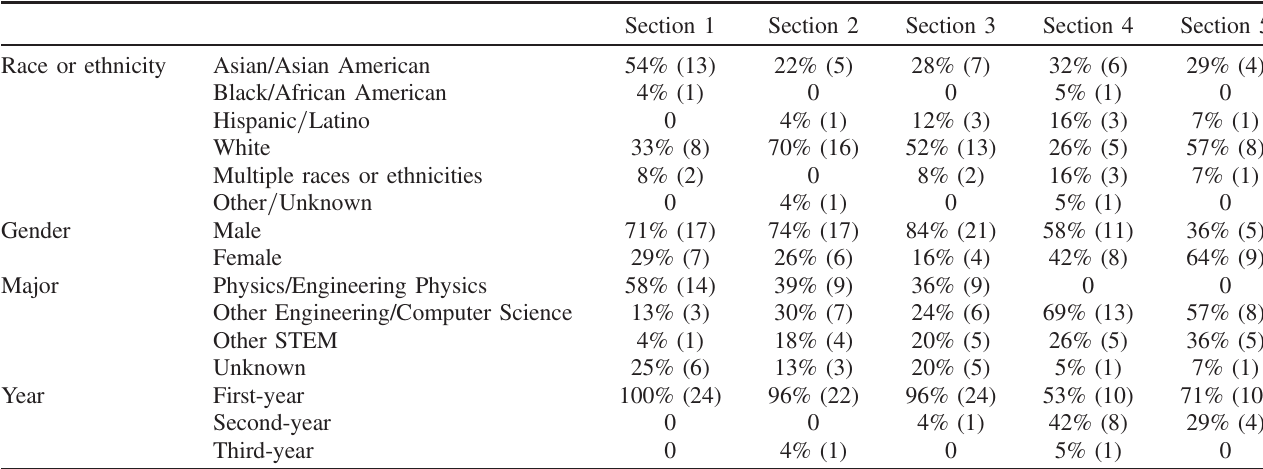
TABLE II. Summary of the self-reported race or ethnicity, gender, intended major, and academic year of students in each lab section. Numbers in parentheses are the N values corresponding to the percentages. For gender, students were given the options of male, female, nonbinary, and self-disclose (with a place to type in their response). All students in this study selected either male or female. We note that the computer science major is partly housed in the engineering school at this institution.